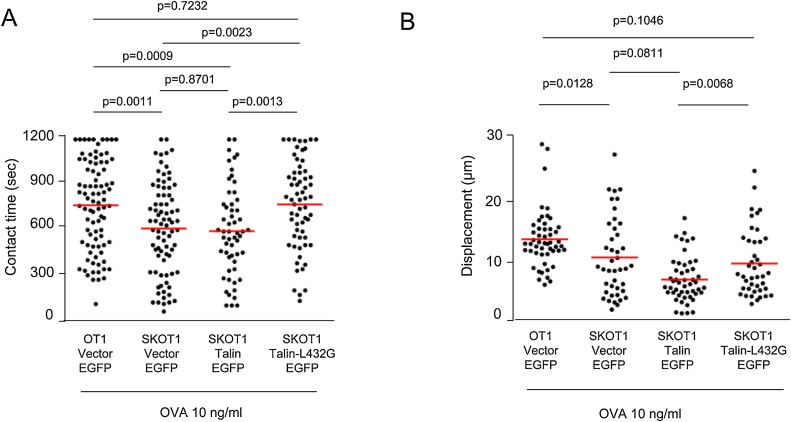
Non-cleavable talin L432G rescued the conjugation defect of SKOT1CTLs. CTLs were transfected with either empty EGFP (EGFP), talin-EGFP or talin-L432G-EGFP vectors. (A) In the presence of DC-OVA, SKOT1CTLs transfected with EGFP ([SKOT1 vector EGFP] mean ± SD, 610.0 ± 33.7 s) showed significant decrease in contact time as compared with OT1 transfected with EGFP. (B) Displacement of SKOT1 CTLs transfected with EGFP were significantly lower in contrast to OT1 CTLs transfected with EGFP in the presence of DC-OVA (p < 0.05). The displacement of SKOT1 CTLs transfected with talin-EGFP was comparable to those transfected with EGFP alone (p > 0.05). Transfection of Talin-L432G into SKOT1 cells restored displacement to levels seen with OT1 cell transfected with EGFP alone in presence of DC-OVA.